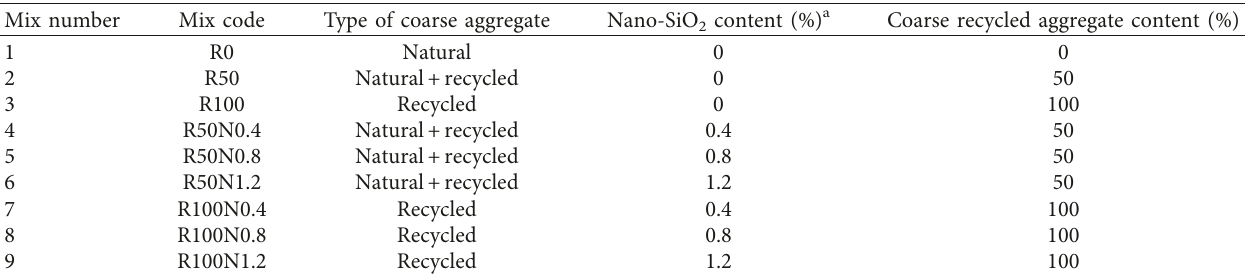
Table 2: Code of mixes and variables of